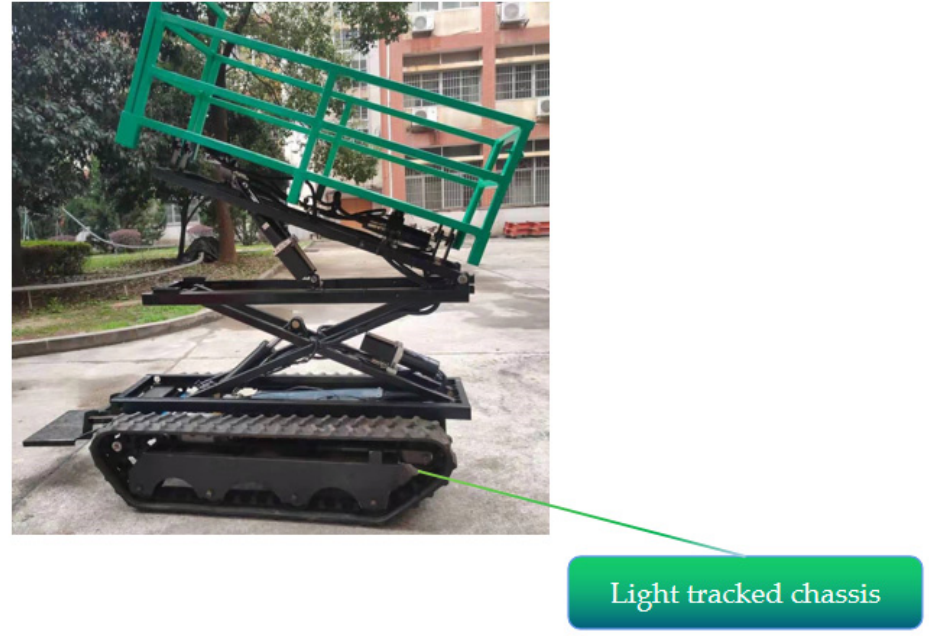
Figure 2. Electric fruit picking platform used for experimental trials.